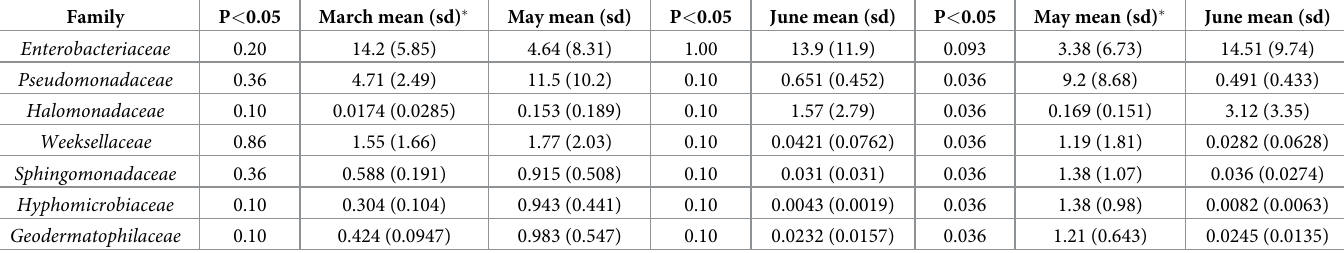
Table 4. Wilcoxon signed rank sum test for March and May on top 8 most abundant families affected by season.